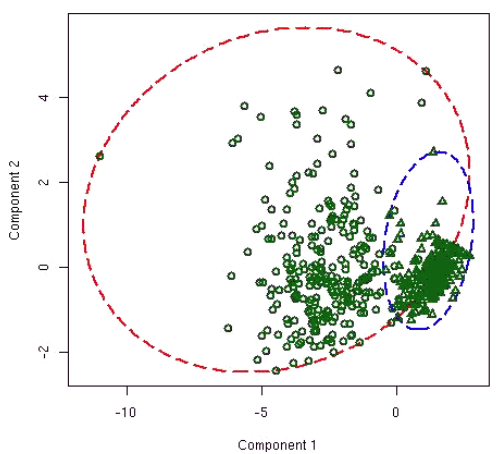
Fig. 25. Reallocated 699 data by KFCM.